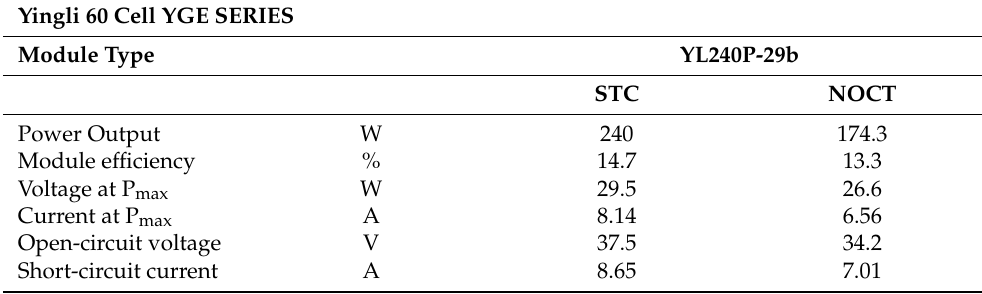
Table A1. Technical data of the PV